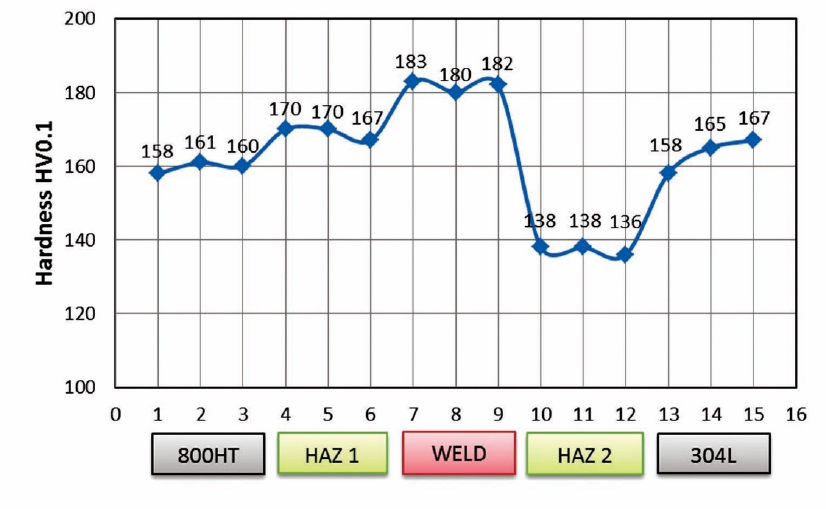
Figure 18. Microhardness distribution across the welded joint.